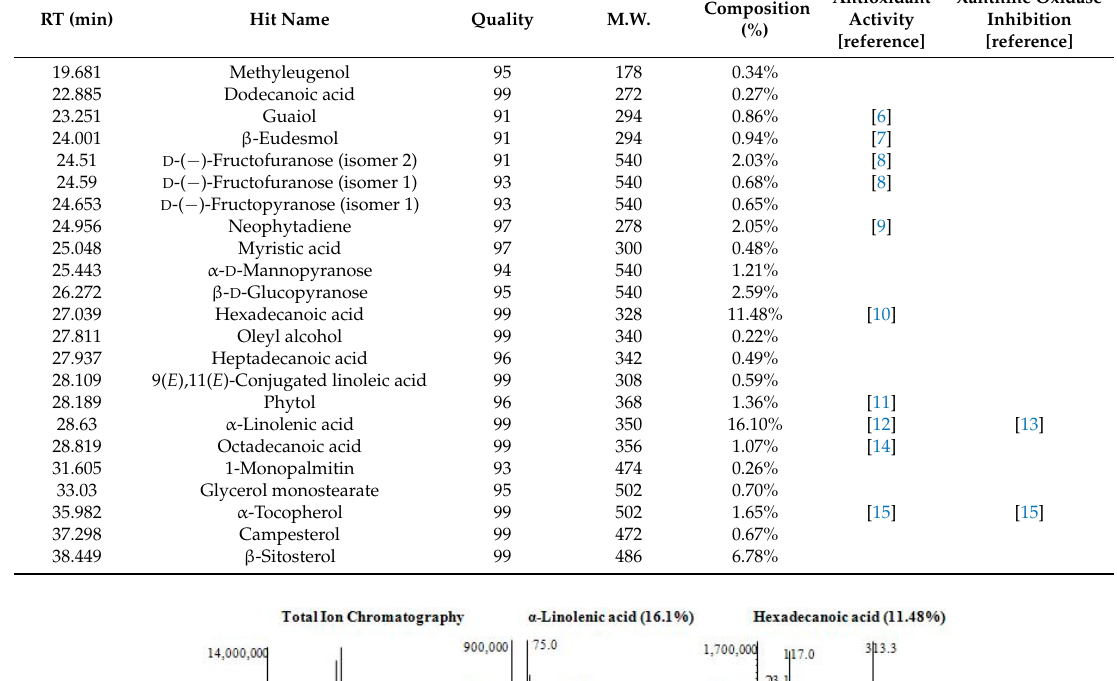
Table 2. Identified substances from the hexane extracts of C.yabunikkei.